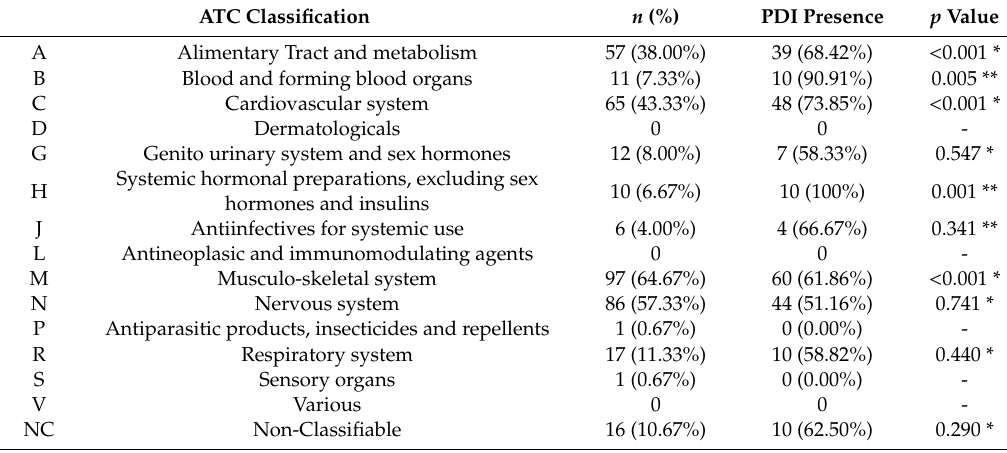
Table 5. Prevalence of drugs involved in Potential Drug Interactions distributed by Anatomical Therapeutic and Chemical Classification (ATC) in adults with severe obesity ( n =